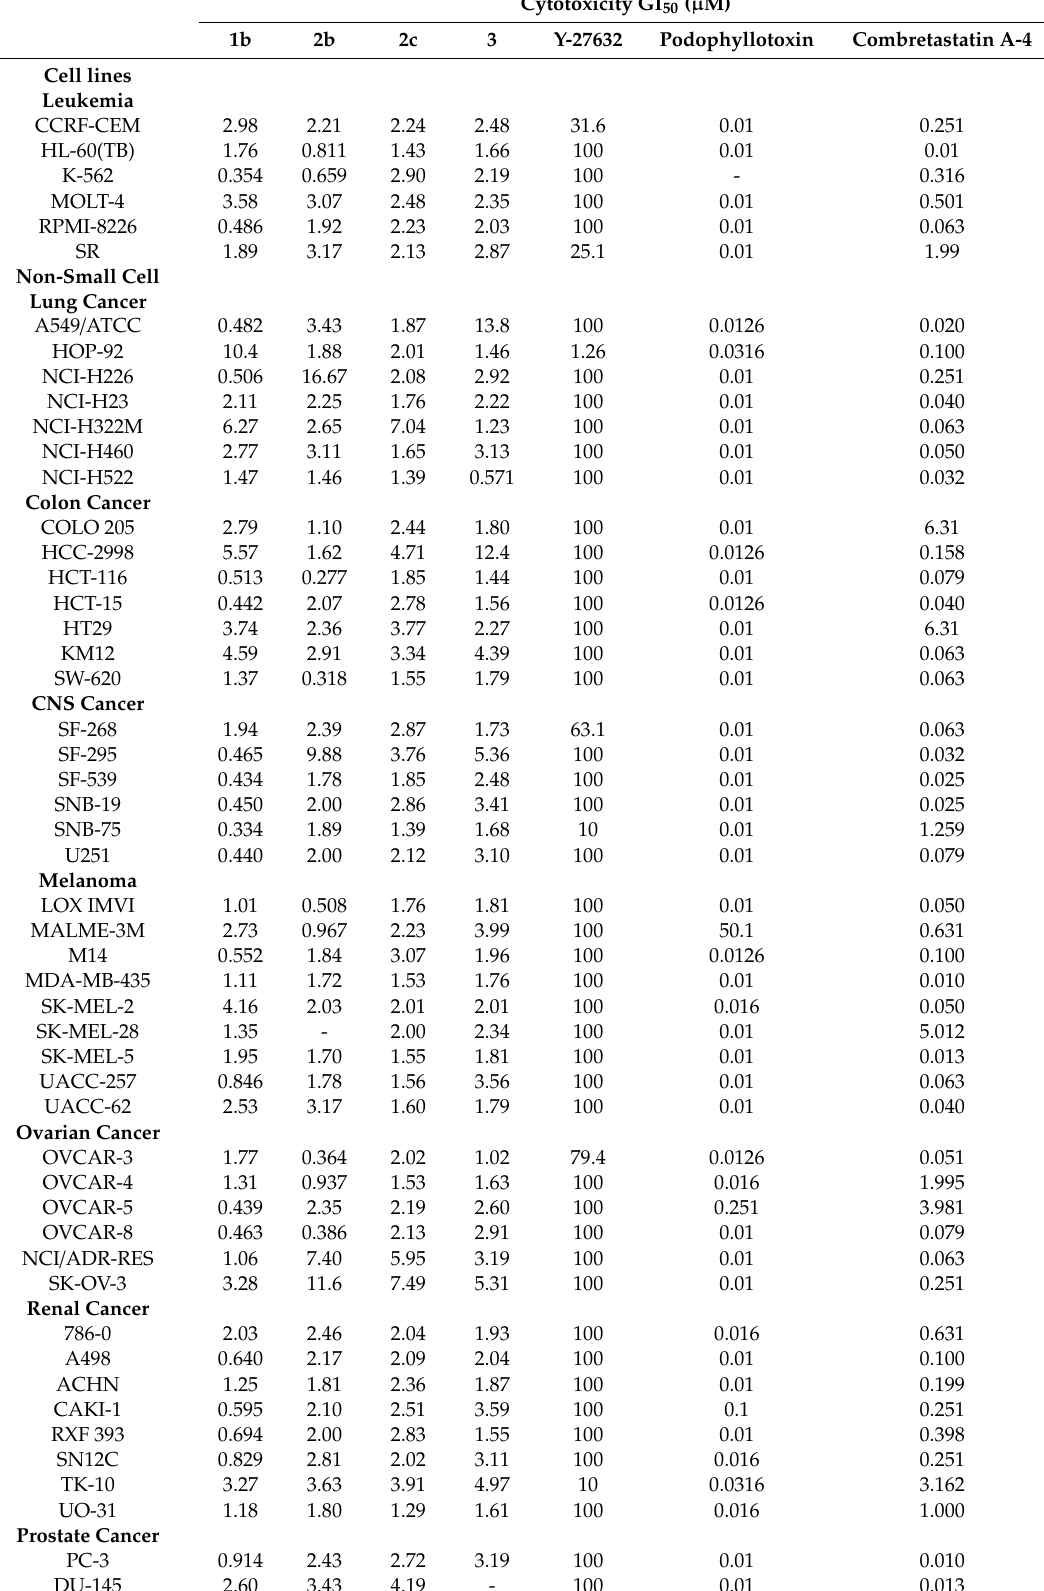
Table 2. Inhibition of in vitro human cancer cell lines by compounds 1a , 2b , 2c and 3 , in comparison with combretastatin A-4, podophyllotoxin and Y-27632 taken as reference